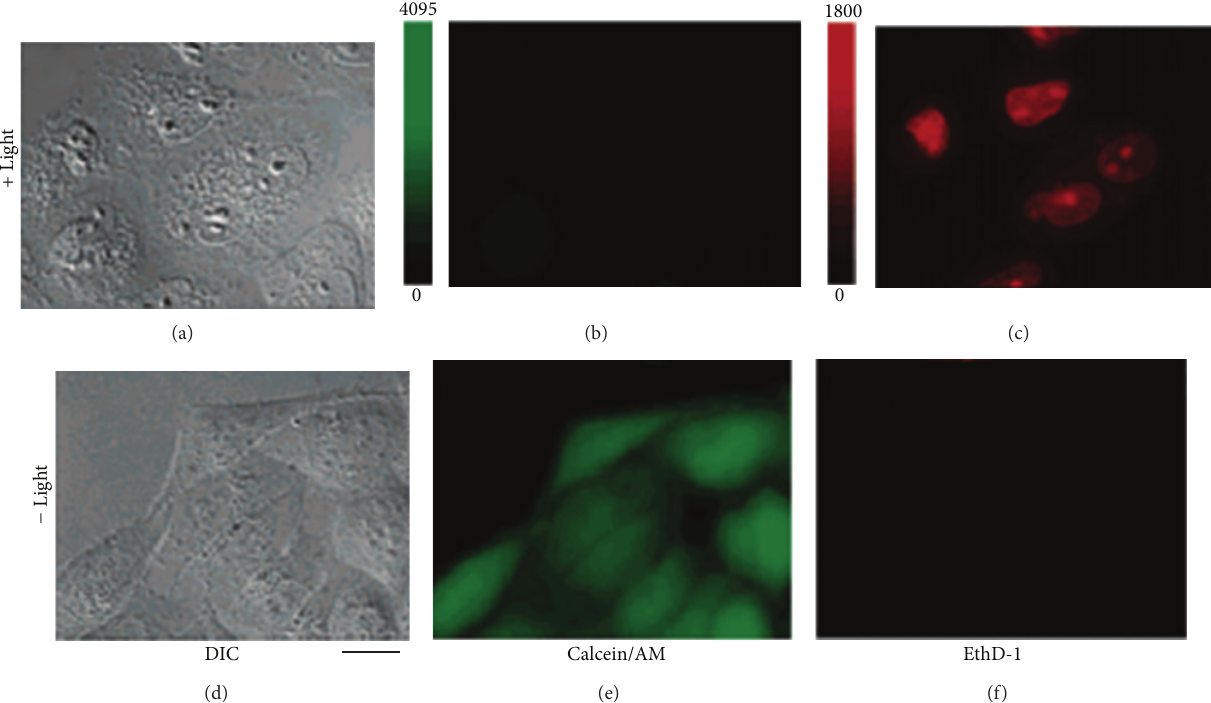
Figure 4: Cell photosensitization by 3. Differential interference contrast and fluorescence and fluorescent images of HeLa cells loaded with calcein AM (living cell marker) and EthD-1 (dead cell marker) before photosensitization (a–c) and after (d–f). Reprinted with permission from [13] Copyright 2005 American Chemical Society.